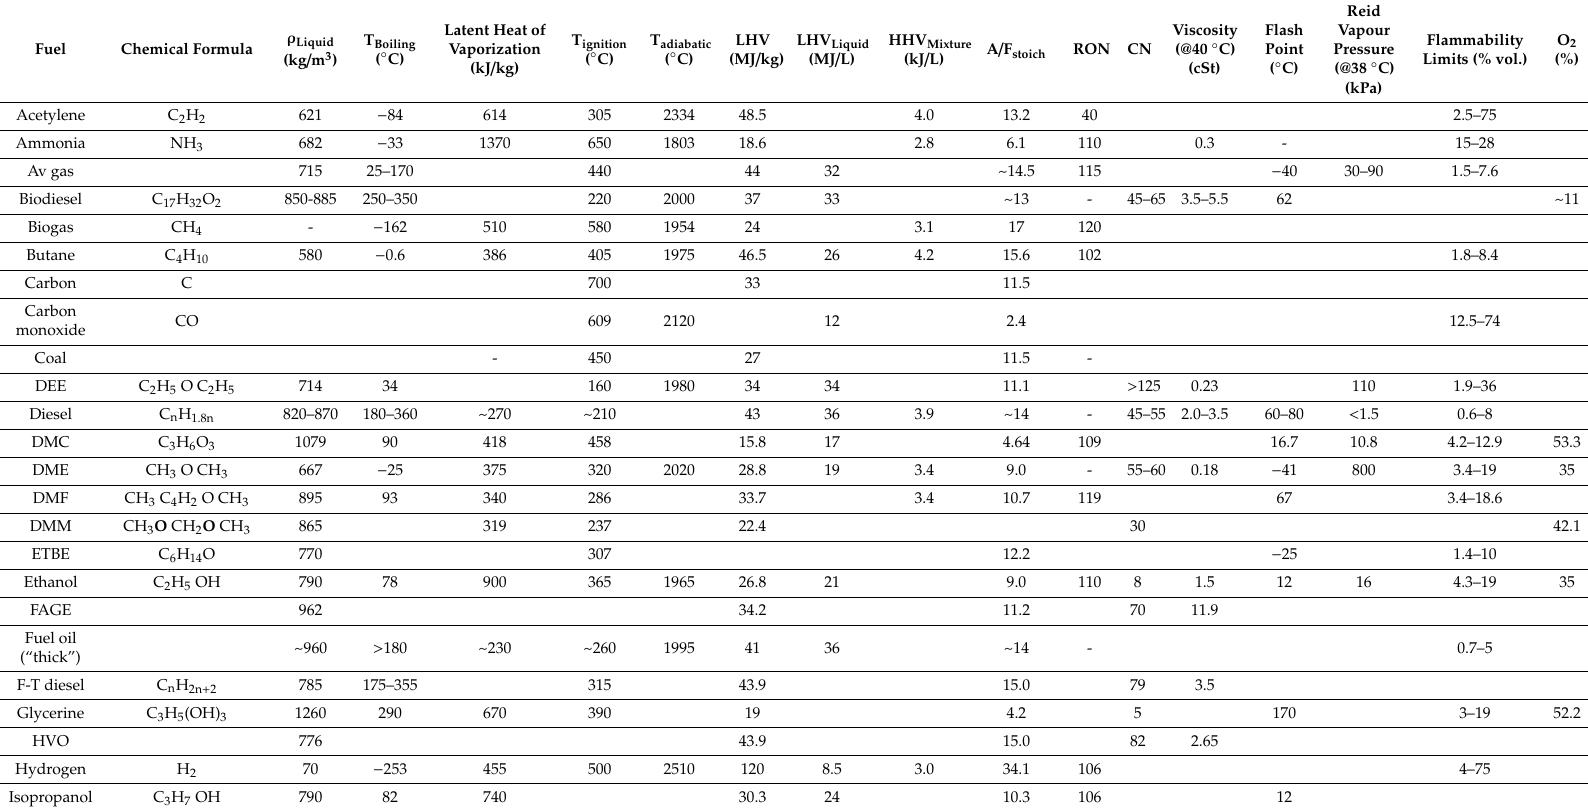
Table 3. Properties for some fuels (adapted from